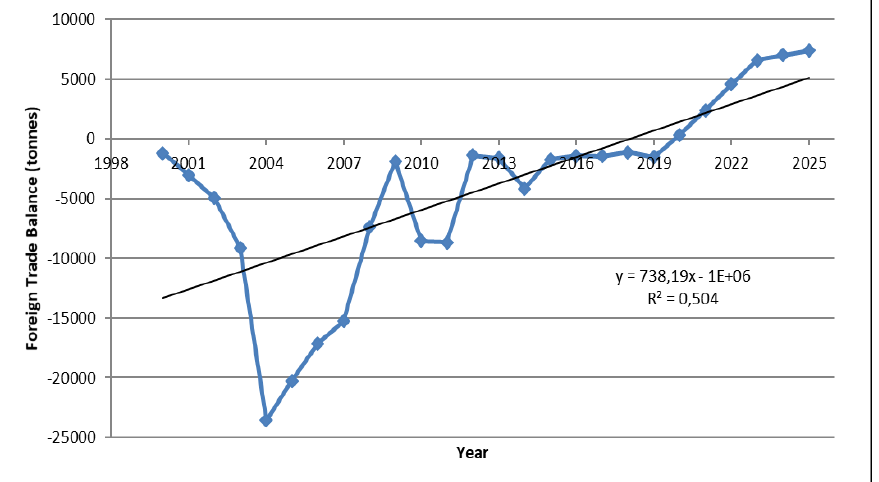
Figure 10. Turkey’s foreign trade balance of oats